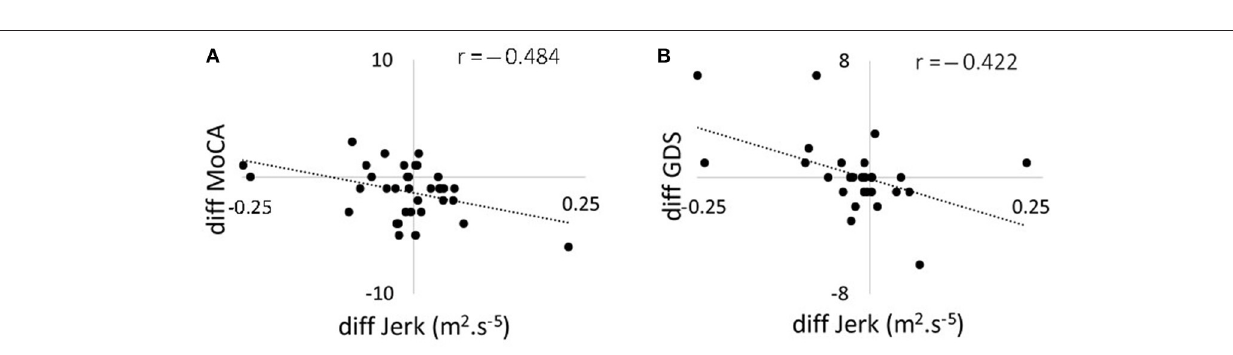
FIGURE 3 | Scatter plots showing the correlation between changes in 120s jerk from 36 to 54 months and (A) changes in MoCA score from 36 to 54 months; (B) changes in GDS from 36 to 54 months. MoCA, Montreal Cognitive Assessment; GDS, Geriatric Depression